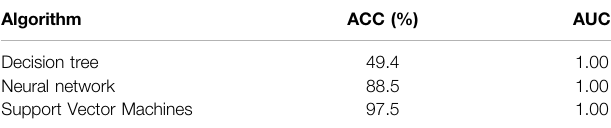
TABLE 3 | Comparison of different algorithm